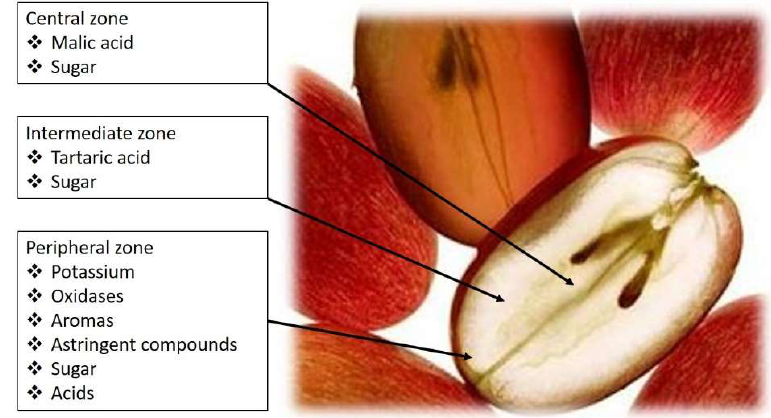
Figure 1. Grape-berry flavor zones and distribution of tartaric and malic acids.